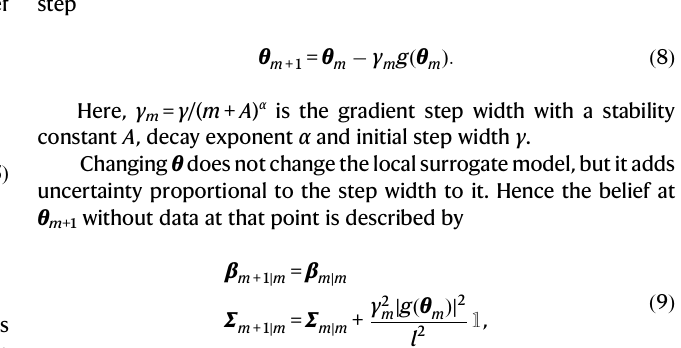
terms of 1 and 2-qubit gates. Here, η = arcsin ð and ϕ ∈ [ − π , π